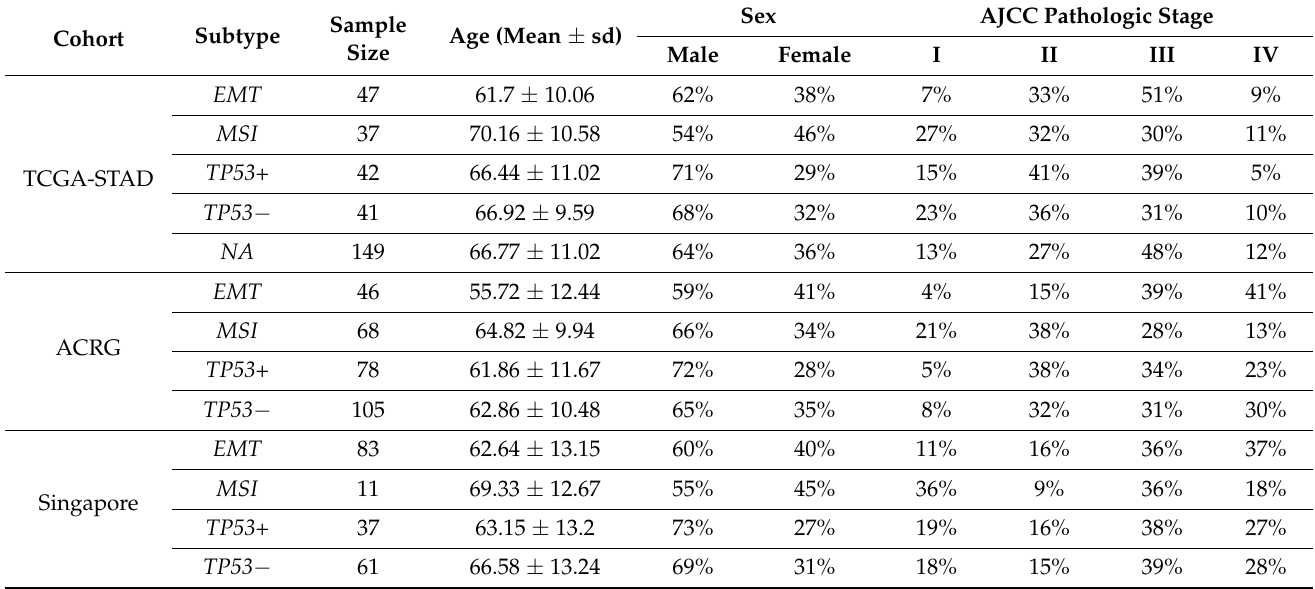
Table 1. The distribution of the clinical information within each subtype for the TCGA-STAD, ACRG, and Singapore